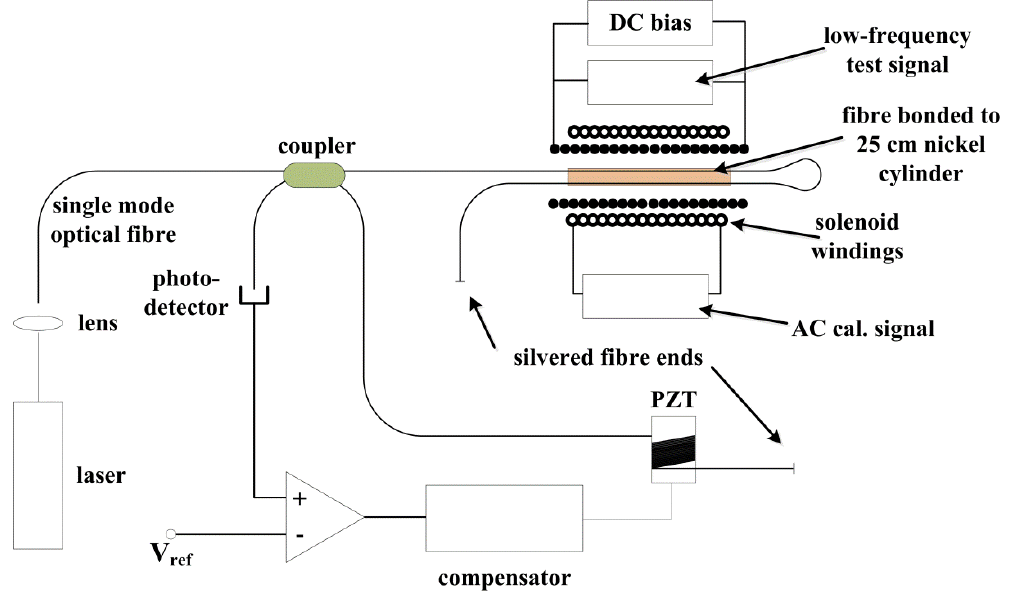
Figure 12. Scheme of the all fiber magnetometer by Kersey et al.